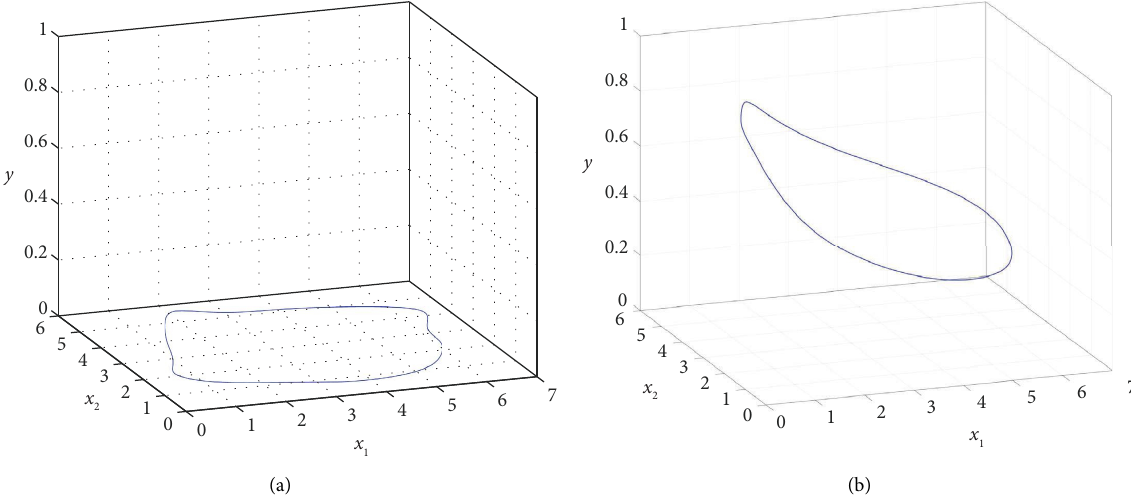
Figure 12: Invariant curves generated by map (37). (a) ( μ ( 1 , 0 . 5 , 0 . 8 , 15 , 0 . 5 , 0 . 61 )